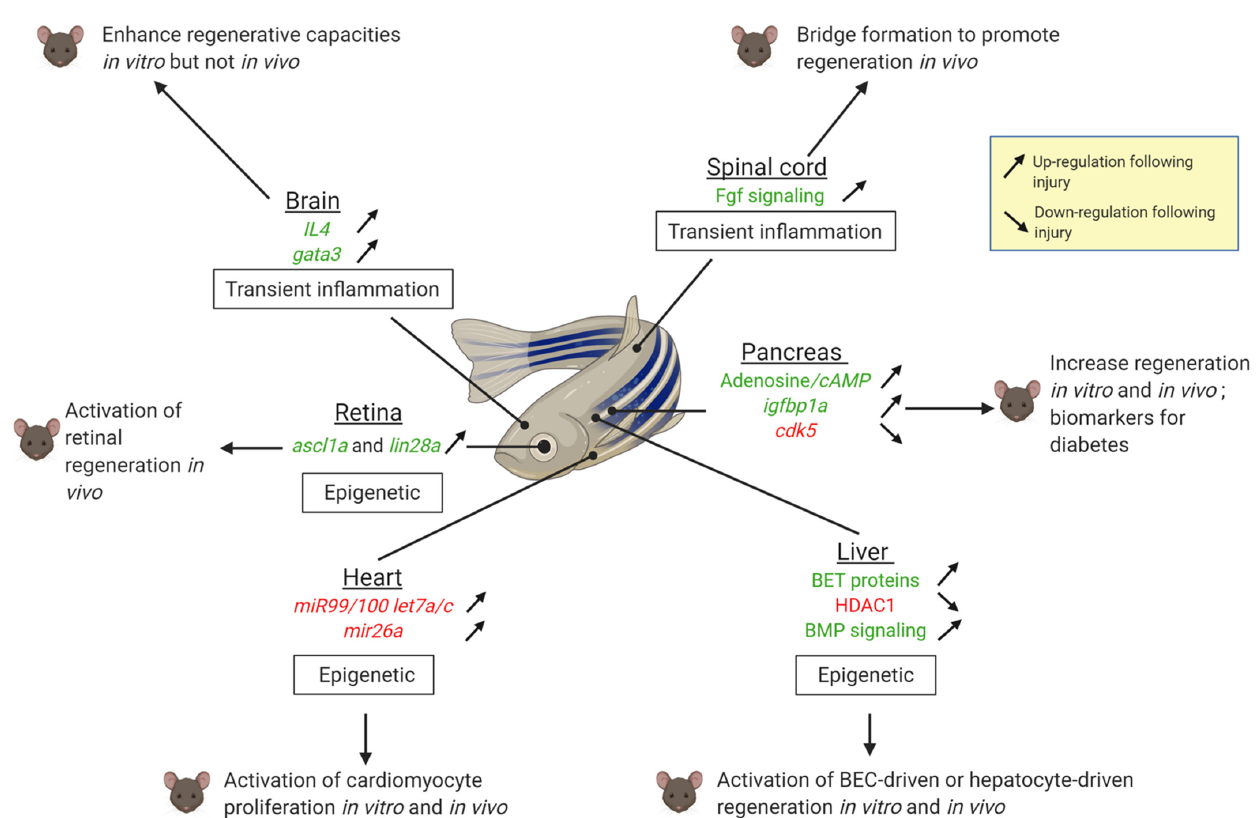
Figure 2. Summary of regenerative mechanisms identified in zebrafish which are able to awake the regenerative potential in mammals in the brain, the spine, the retina, the pancreas, the liver and the heart. The up-headed (vs. back-headed) arrows mean that the expression is upregulated (vs. downregulated) in zebrafish after injury. Factors highlighted in green exert positive effect in regeneration, those in red impair regeneration. Created with Biorender.com.